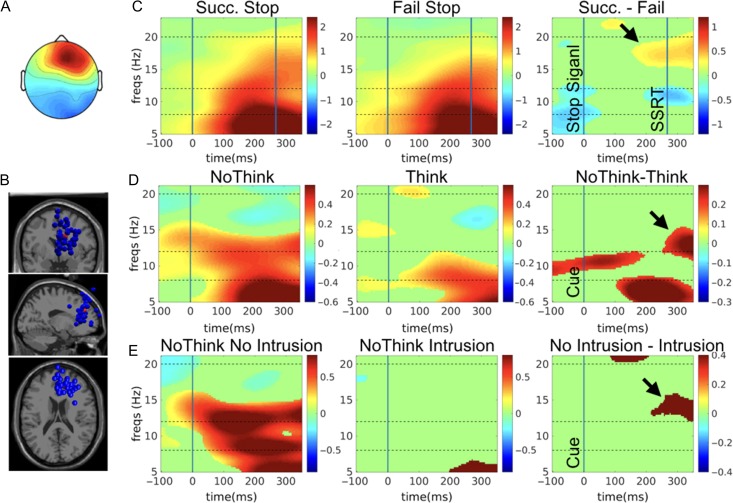
Event-related spectral perturbations for the right frontal component. (A) The right frontal topography representing the mean scalp projection map of automatically clustered right frontal components from 41 participants. (B) The estimated equivalent dipole locations of the independent component in each participant (blue spheres) and their centroid (red sphere) visualized in the MNI template brain. (C) ERSP analysis for the stop signal task. There is increased right frontal beta band power for successful vs. failed stop trials before SSRT. (D) ERSP for No-Think vs. Think. There is increased early right frontal beta power for No-Think vs. Think trials. (E) ERSP for intrusion analysis on No-Think trials. There is increased early right frontal beta power for No-Think trials without an intrusion. All maps are masked for significance (P < 0.05) and FDR-corrected for multiple comparisons. The units of power are dB.